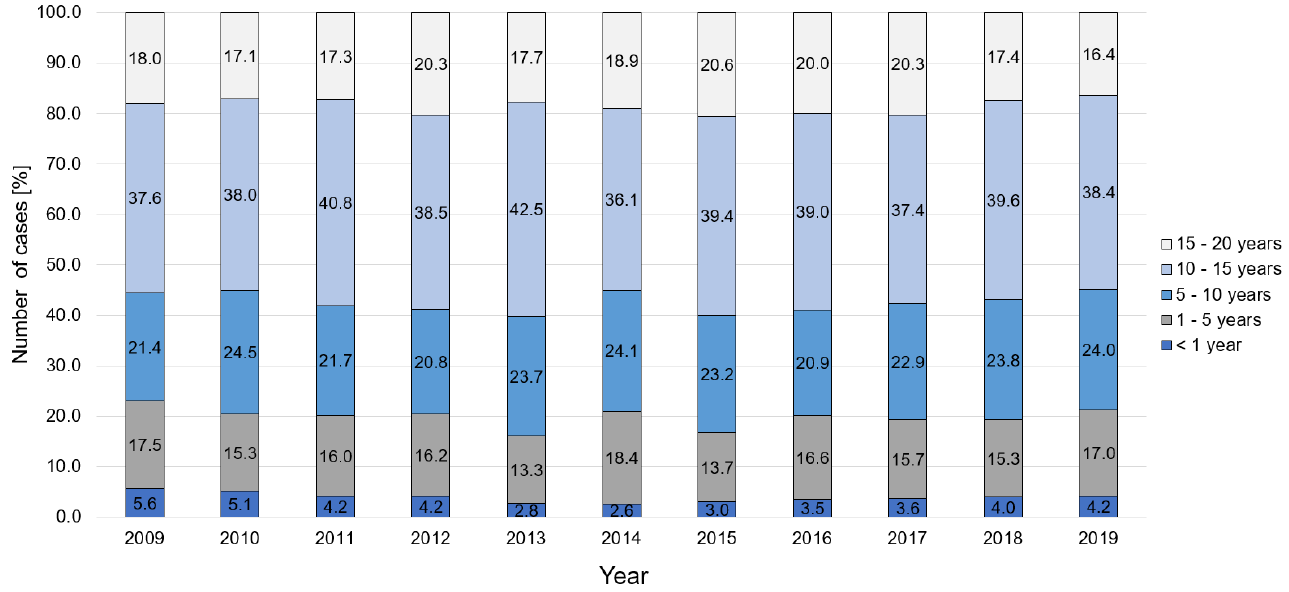
Figure 1. Development of osteomyelitis incidence from 2009 to 2019, divided by gender. The light grey bars present the incidence of male cases, and the dark grey bars present the incidence of female cases.